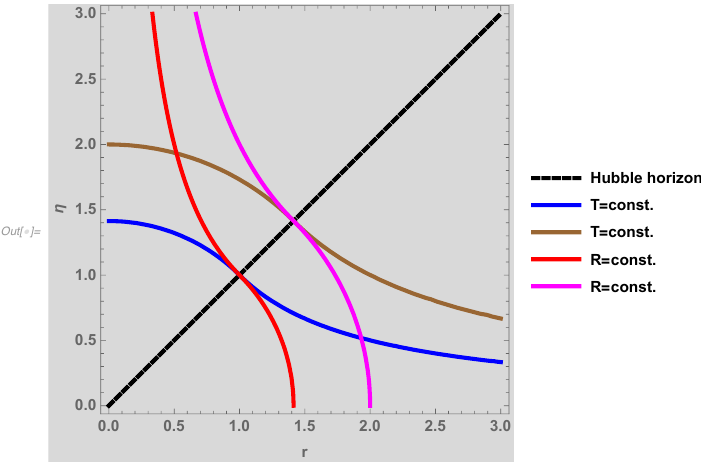
Figure 2 . Constant static time ( T ) and space ( R ) slices in the cosmological ( η, r ) plane (in the unit of H e = 1 ). The T = const. slices in the sub-Hubble region are circular due to (3.9) while they varies inversely with r in the super-Hubble region due to (3.11). The R = const. slices behaves exactly in a reverse manner due to (3.9) and (3.12). The intersection points are located on the light-cone boundary (at the Hubble scale) and there is no horizon for the static observer at the Hubble scale. The comoving Hubble radius is shown in black dotted line. Note that they provide a well-defined Cauchy slicing of the full